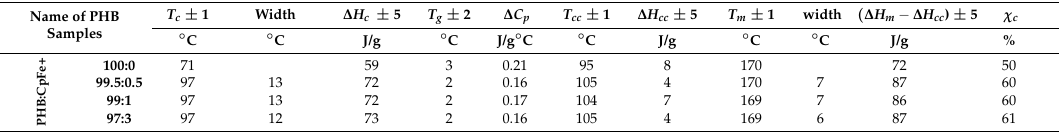
Table 1. Thermal parameters of the pure PHB and PHB/CpFe + nanocomposites from DSC (cool and second heating)